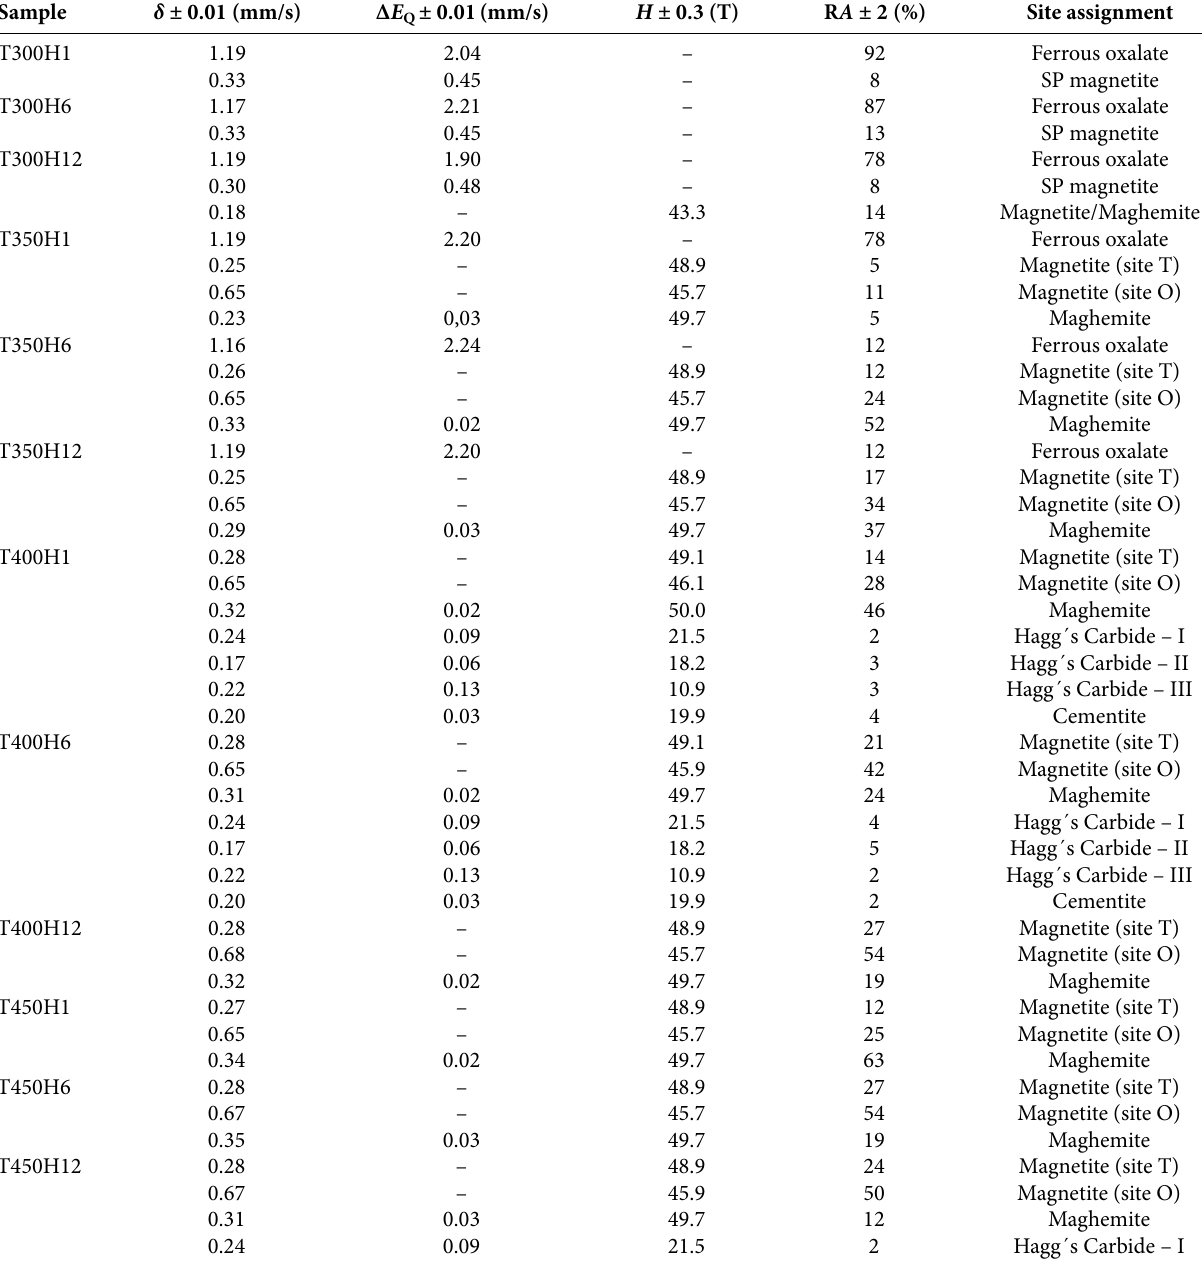
Table 2. Mössbauer parameters of the measured